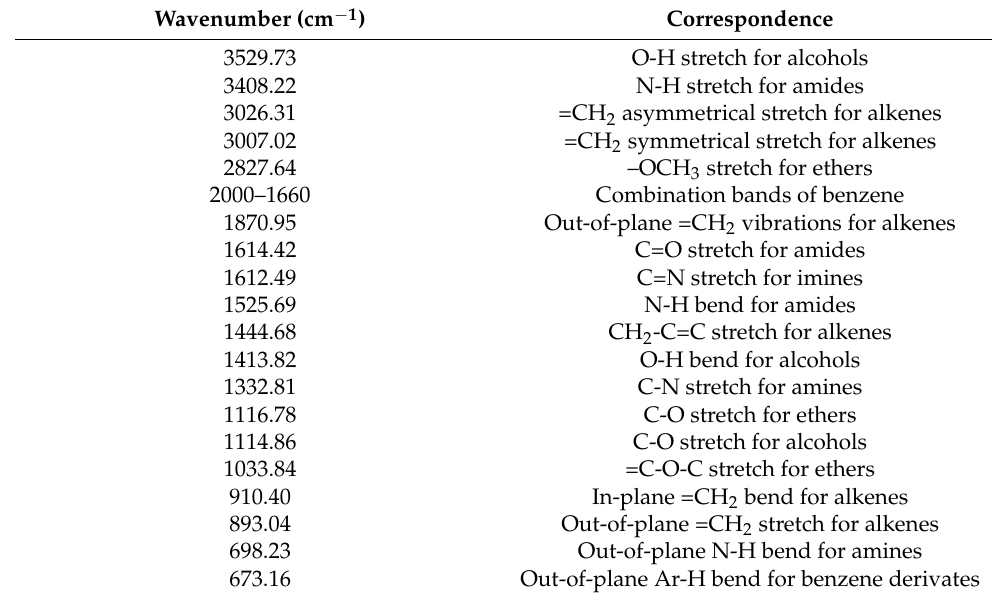
Table A1. Correspondence of bands of the co-polymer IR